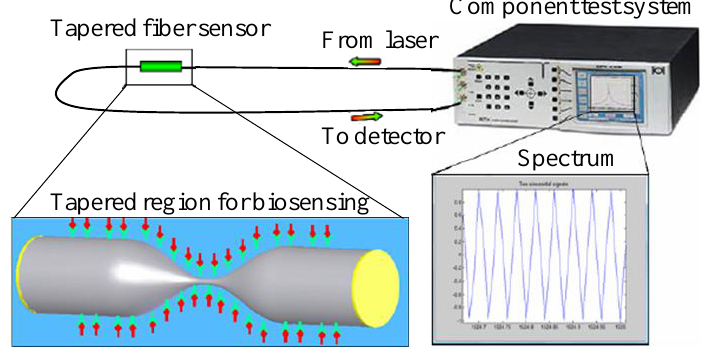
Figure 6. The CTS was used to excite laser into one end of the tapered fiber sensor, and monitor the transmission spectrum from the other end. The bio-target bonding in the tapered region could be analyzed through phase shift of the